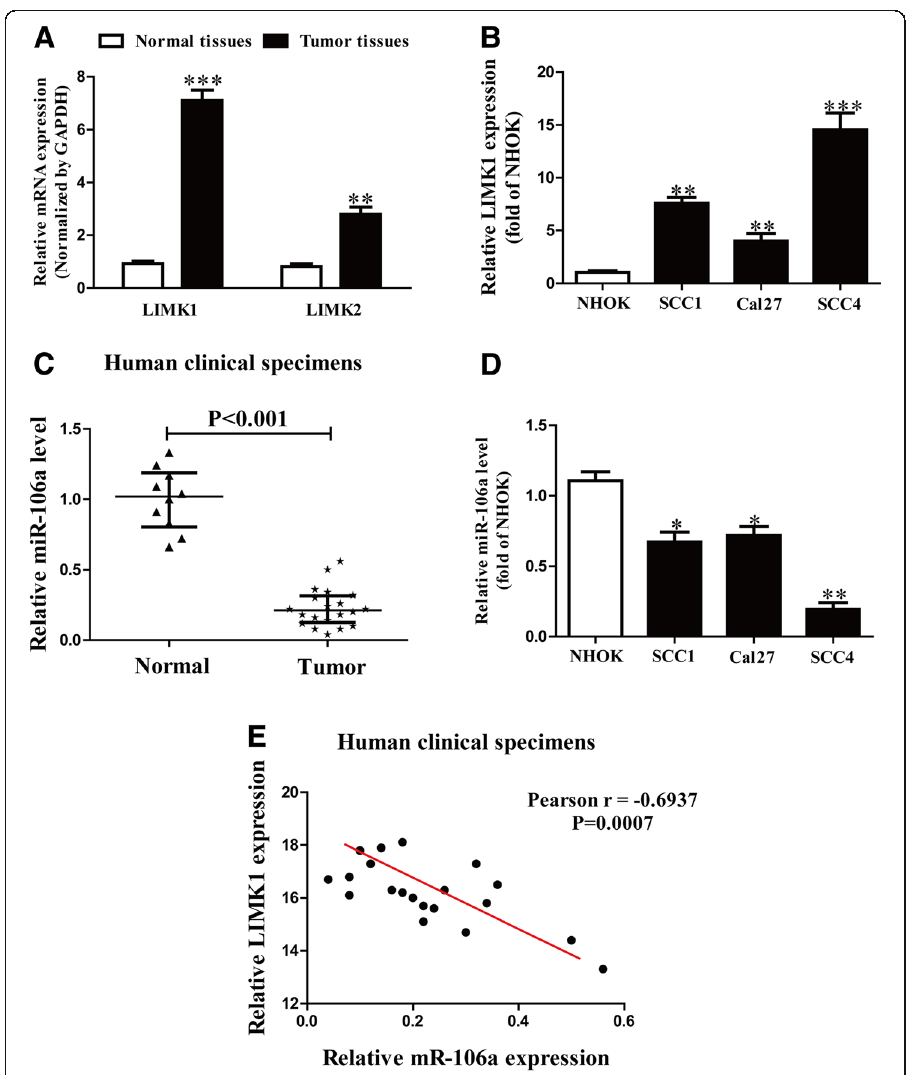
Fig. 1 The expressions of LIMK1 and miR-106a in OSCC tissues and cell lines. a Quantitative RT-PCR analysis of LIMK1 and LIMK2 expressions in OSCC tissues ( n = 20) and adjacent normal tissues ( n = 10). Transcript levels were normalized to GAPDH expression. b Relative LIMK1 expression analyzed via quantitative RT-PCR in three OSCC cell lines normalized to GAPDH ( n = 6). c Quantitative RT-PCR analysis of miR-106a level in OSCC tissues and adjacent normal tissues. Transcript levels were normalized to U6. d Relative miR-106a level analyzed via quantitative RT-PCR in three OSCC cell lines normalized to U6 ( n = 6). e Pearson ’ s correlation analysis of the relative expression levels of miR-106a and the relative LIMK1 mRNA levels in OSCC tissues. All data are presented as means ± SEM. * p < 0.05, ** p < 0.01, *** p < 0.001 vs. normal tissues or